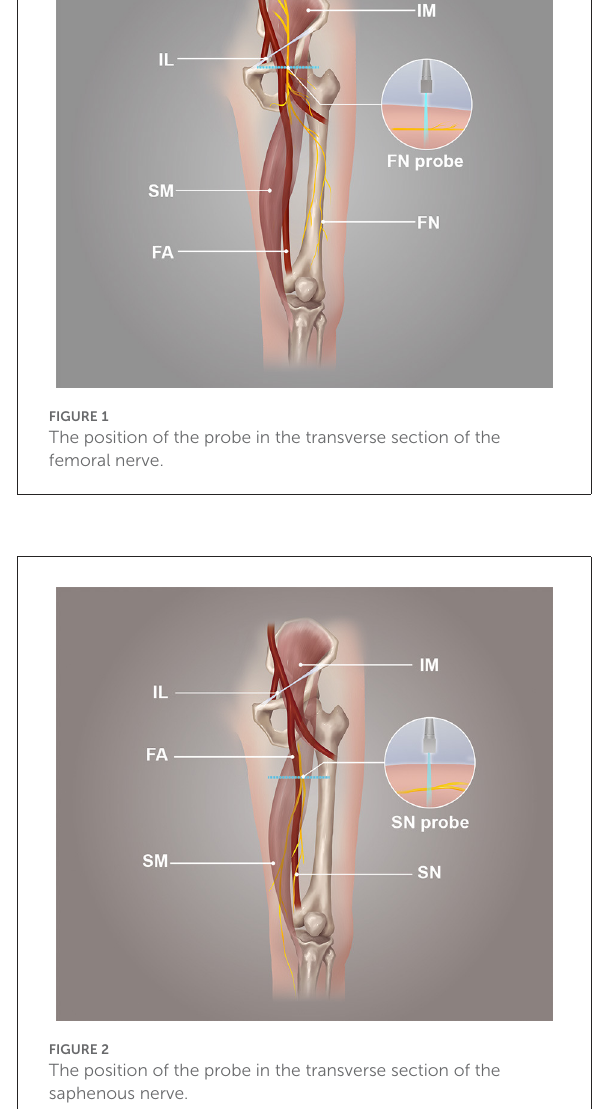
hardness, and the red color indicated a harder average hardness (Figure